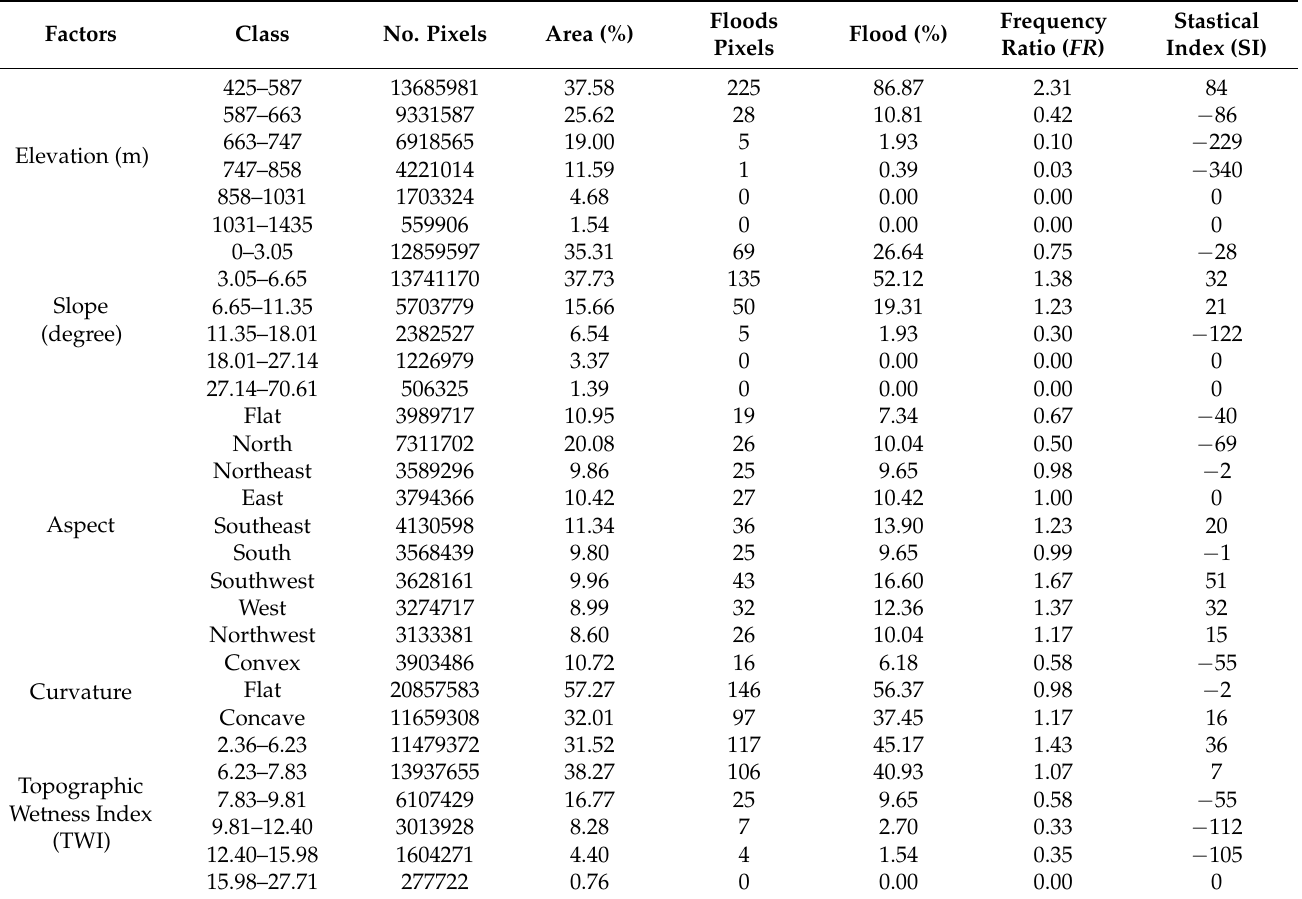
Table 2. Result of the FR and SI model for different classes of the